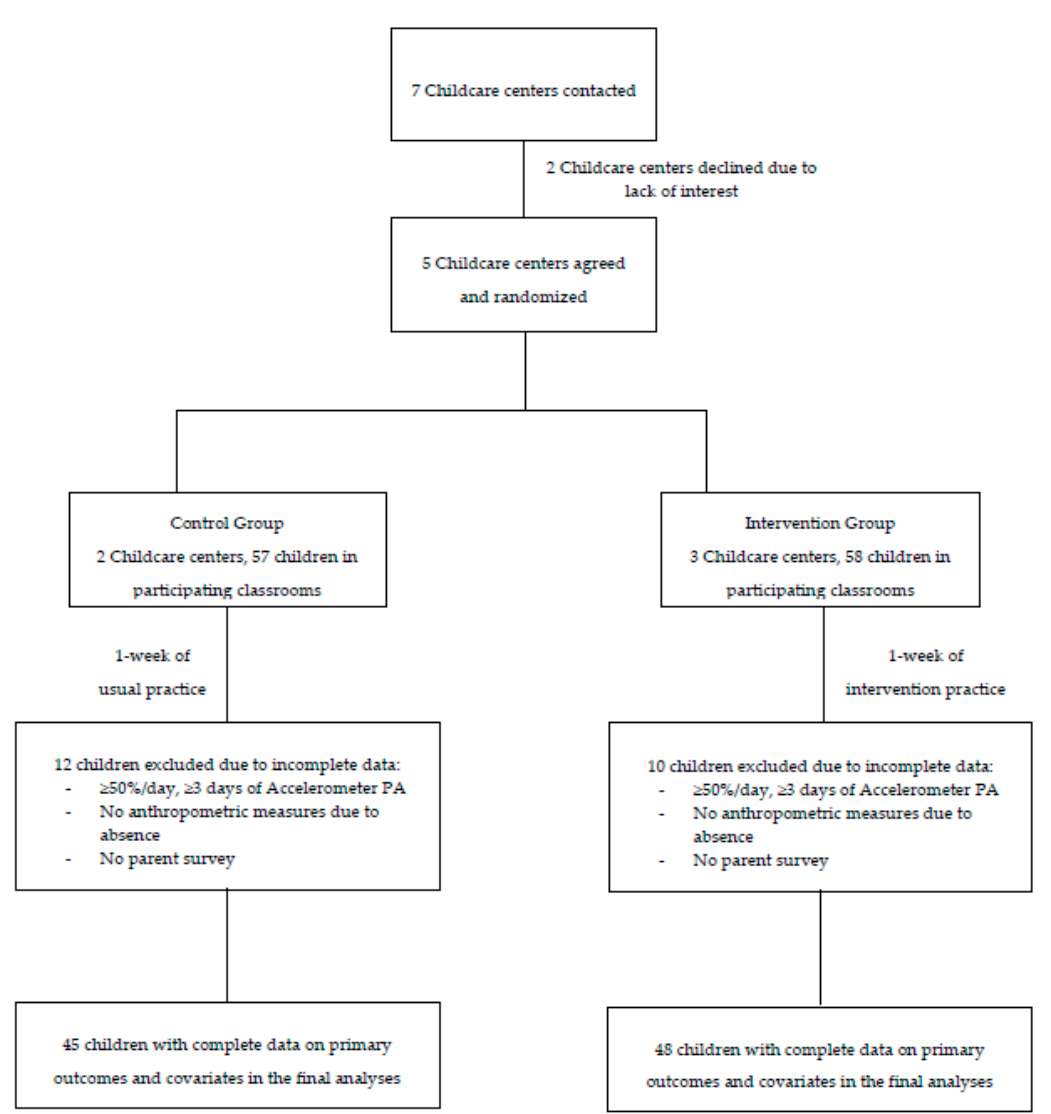
Figure 1. Flow diagram of participant recruitment and data analysis process.